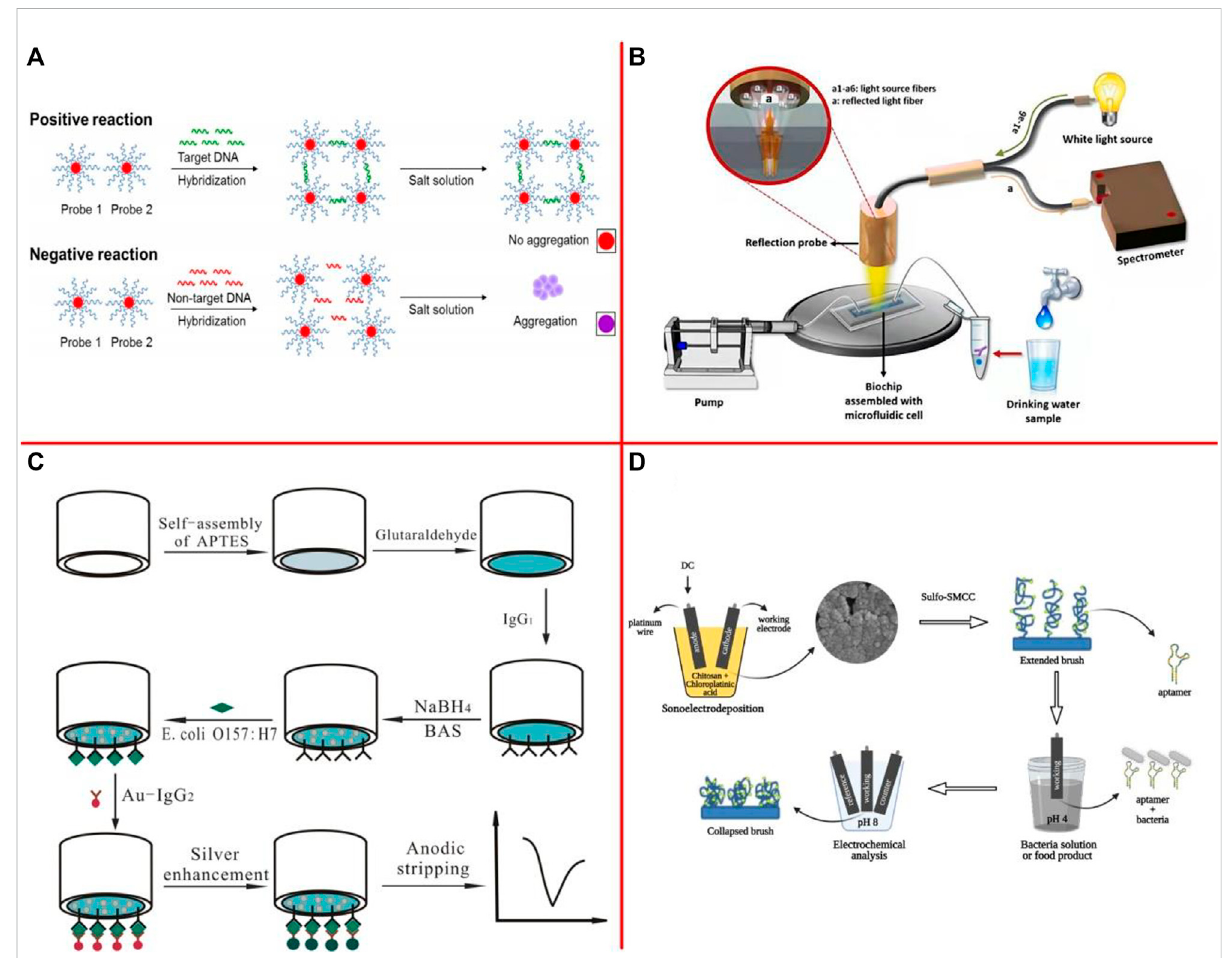
FIGURE 5 (A) The novel principles behind AuNPs optical biosensing and the schematic representation of DNA sandwich hybridization targeting ttrRSBCA locus of Salmonella spp. (Quintela et al., 2019); (B) Illustration of the white light re fl ectance spectroscopy (WLRS) optical setup and sensing and sensing principle(Angelopoulouetal.,2021); (C) Schematic diagramofelectrochemicaldetection of E.coli O157:H7 bygold nanoparticle-catalyzed silver enhancement at porous pseudo-carbon paste electrode (Xu et al., 2012); (D) Fabrication, biofunctionalization, and sensing scheme of CHI/Pt aptasensor (Oliveira et al.,